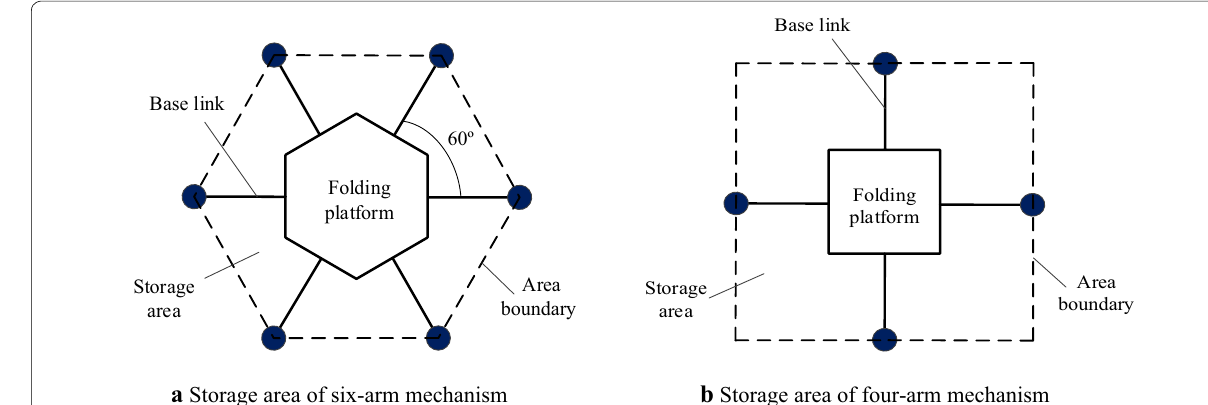
Figure 3 Storage area of the mechanisms with six and four